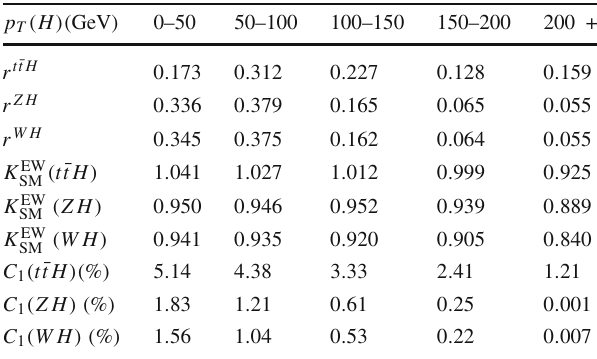
Table 5 Ratio of the cross section, NLO EW K-factor, and C 1 in dif- ferent bins of p T ( H ) for t ¯ tH , Z H and W H